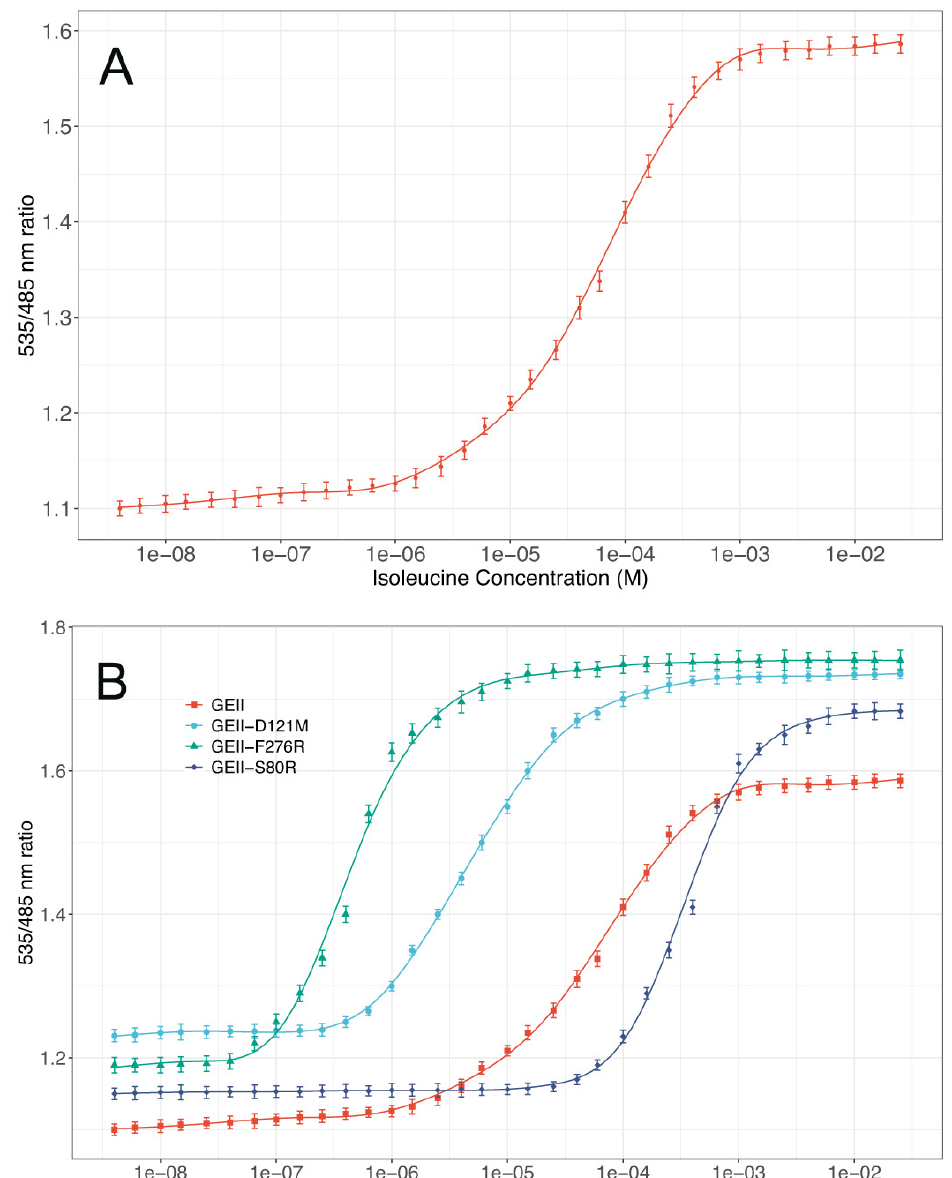
Figure 4. ( A ) Dissociation constant (K d ) analysis of the GEII sensor in vitro by fitting the ligand titration curve at 300 K to a single binding isotherm equation. K d equals the half-maximal saturation point on the sigmoidal curve. In this case, K d equals 63 ± 6 μ M. ( B ) Ligand binding isotherms for a library of affinity mutants of the GEII sensor. While, GEII-S80R showed reduced affinity relative to GEII, the other two mutants, GEII-F276R and GEII-D121M, had markedly improved affinities for isoleucine. The continuous lines correspond to the best fit curve for titration data obtained by non-linear regression using Generalized Additive Model (GAM) with cubic regression splines.